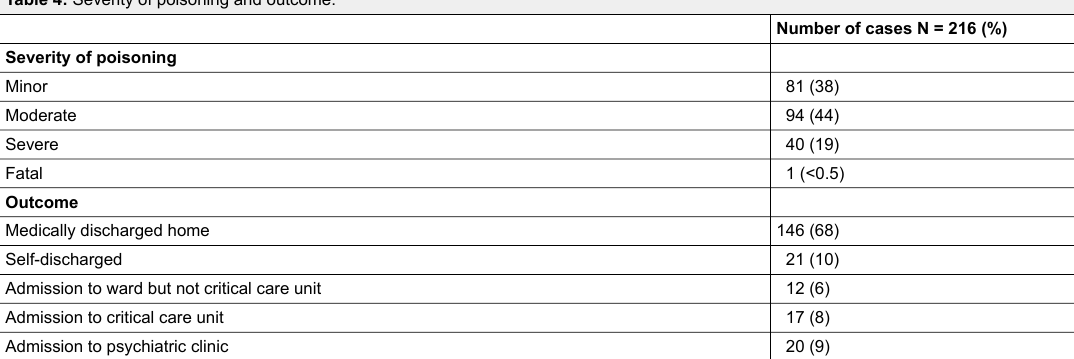
Table 4: Severity of poisoning and